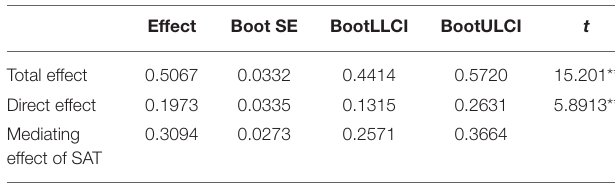
TABLE 7 | Total effect, direct effect, and mediating effect.